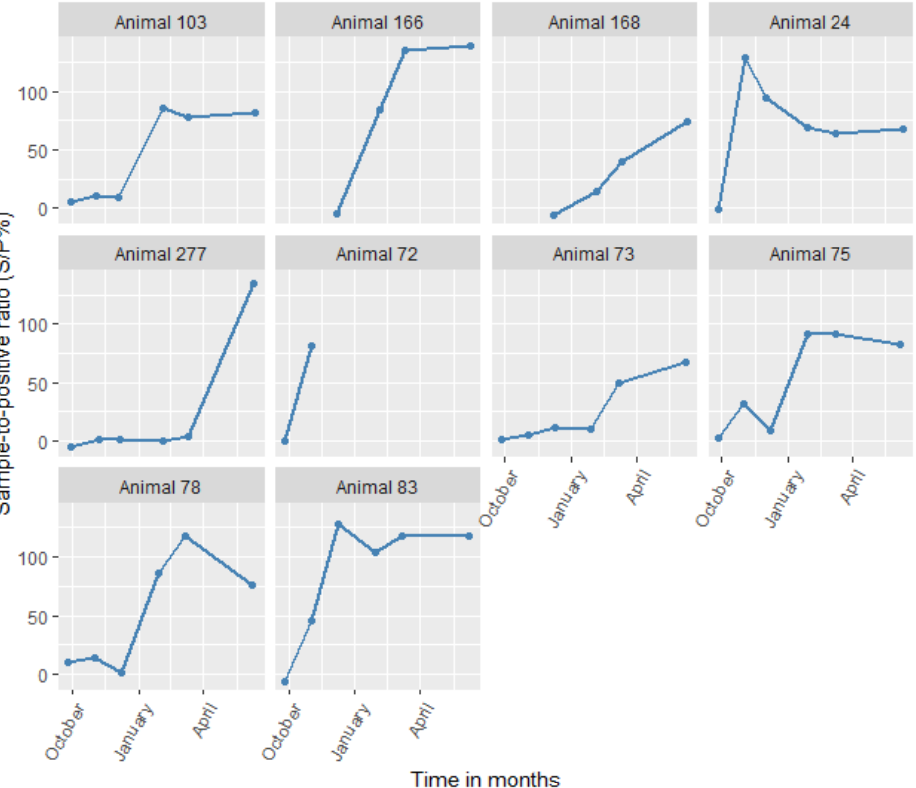
Figure 4. Changes in antibody levels for all animals that seroconverted to Coxiella burnetii (in S/P%) with time.